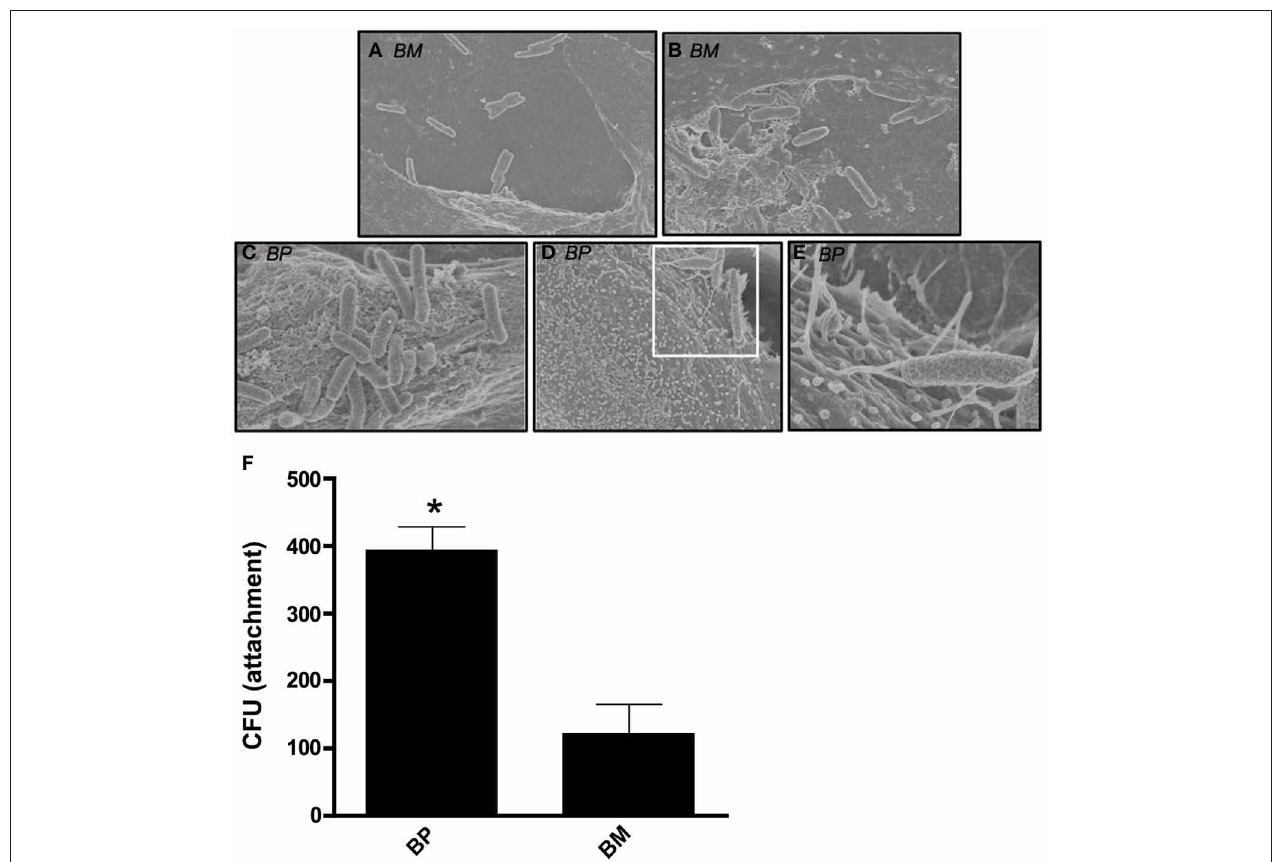
FIGURE 1 | B. mallei ( BM ) and B. pseudomallei ( BP ) interaction with primary human ATII cells (ATII cells). ATII cells were grown on 3.0-um transwell filters to confluence prior to apical exposure of BM and BP at an MOI of approximately 100:1 for 4h. Minimal contact of BM ( A and B ) with ATII cells was visualized via SEM. However, BP (C–E) adhesion to the apical